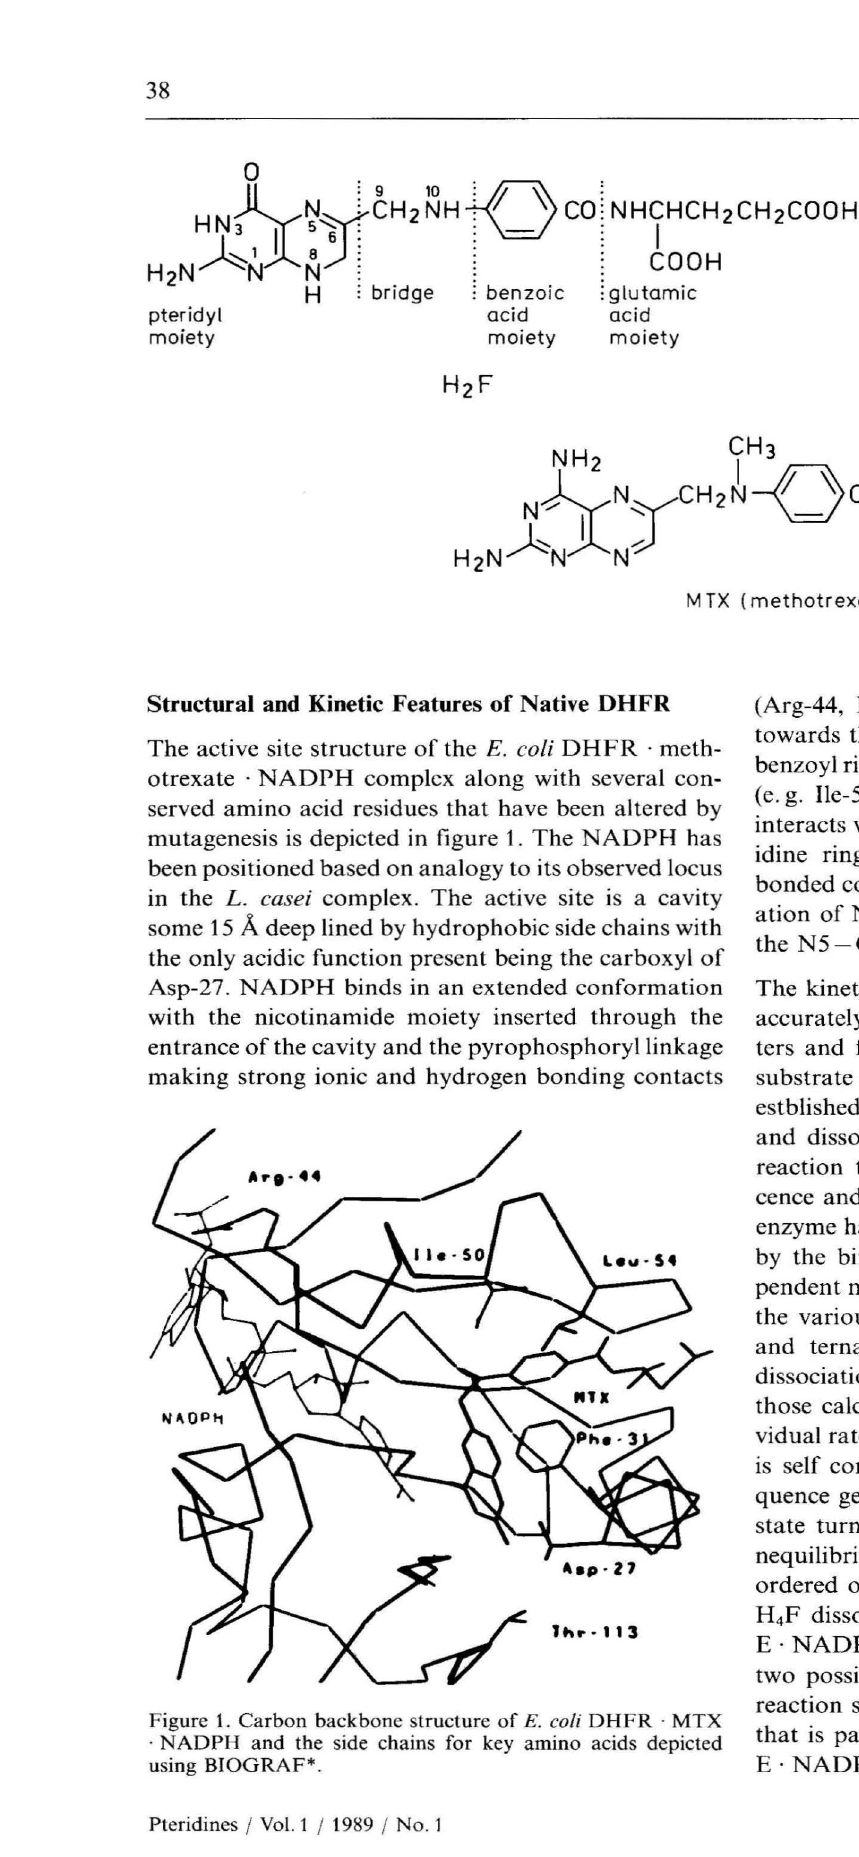
Figure 1. Carbon backbone structure of E. coli DHFR . MTX . NADPH and the side chains for key amino acids depicted using